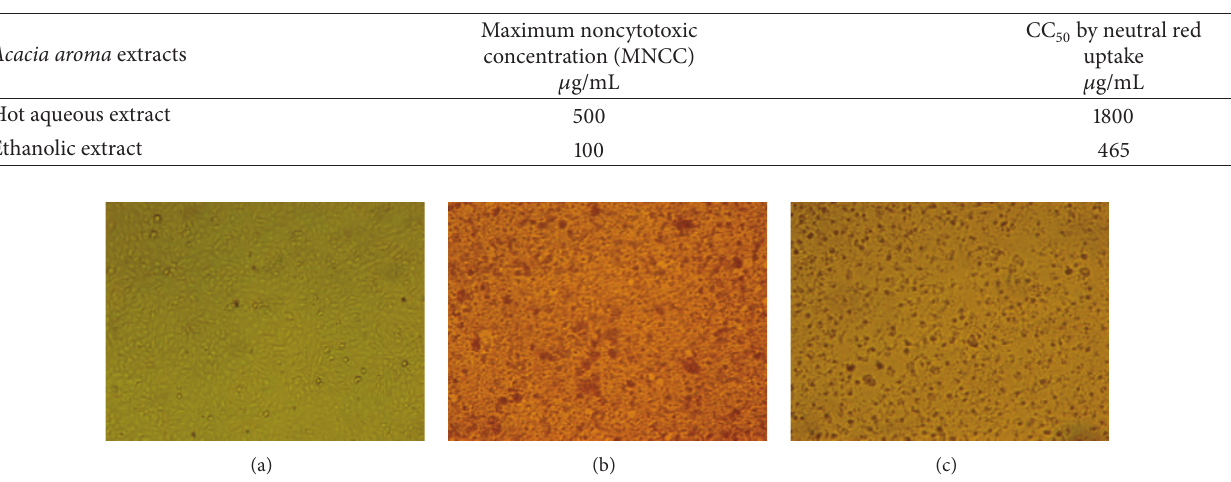
Figure 1: Morphological alterations of monolayers of Vero cells induced by A. aroma extracts, 20x. (a) Hot aqueous extract; (b) ethanolic extract; and (c) cell control.